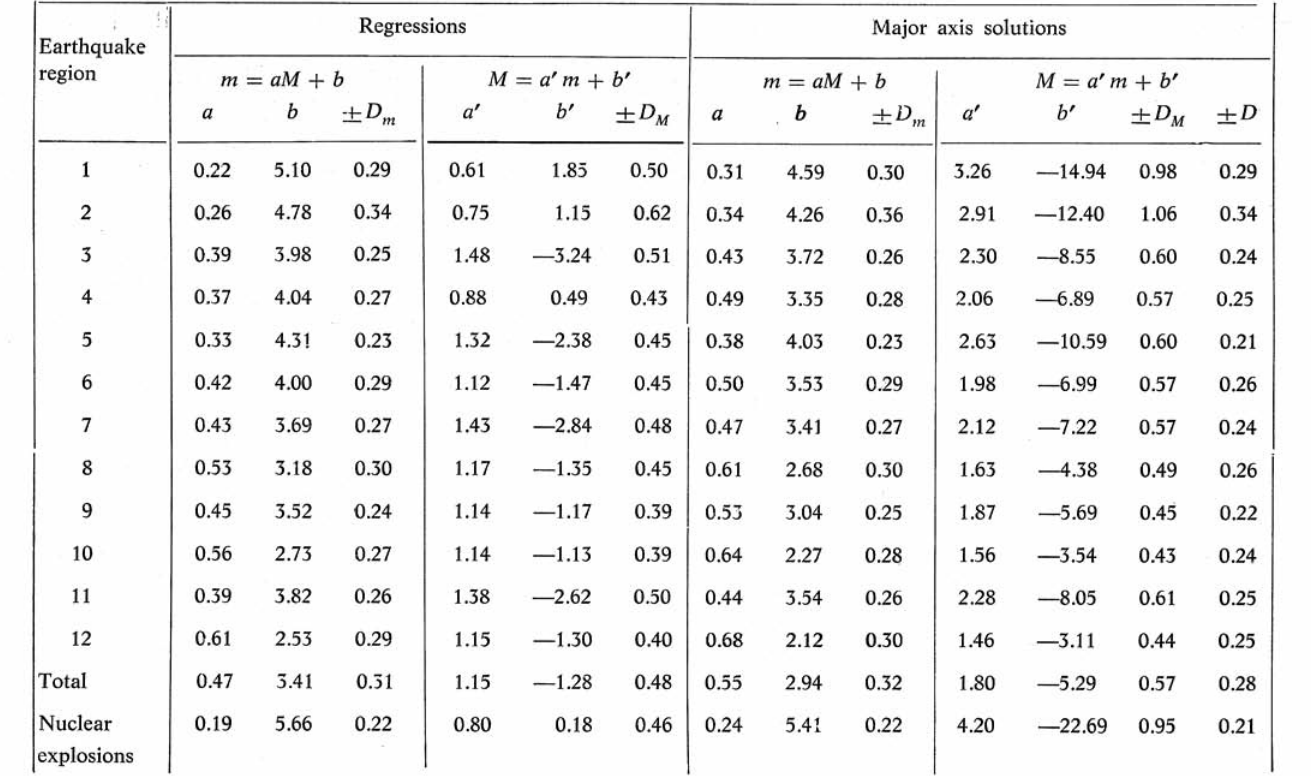
Table 2. Relations between m and M for h ≤ 50